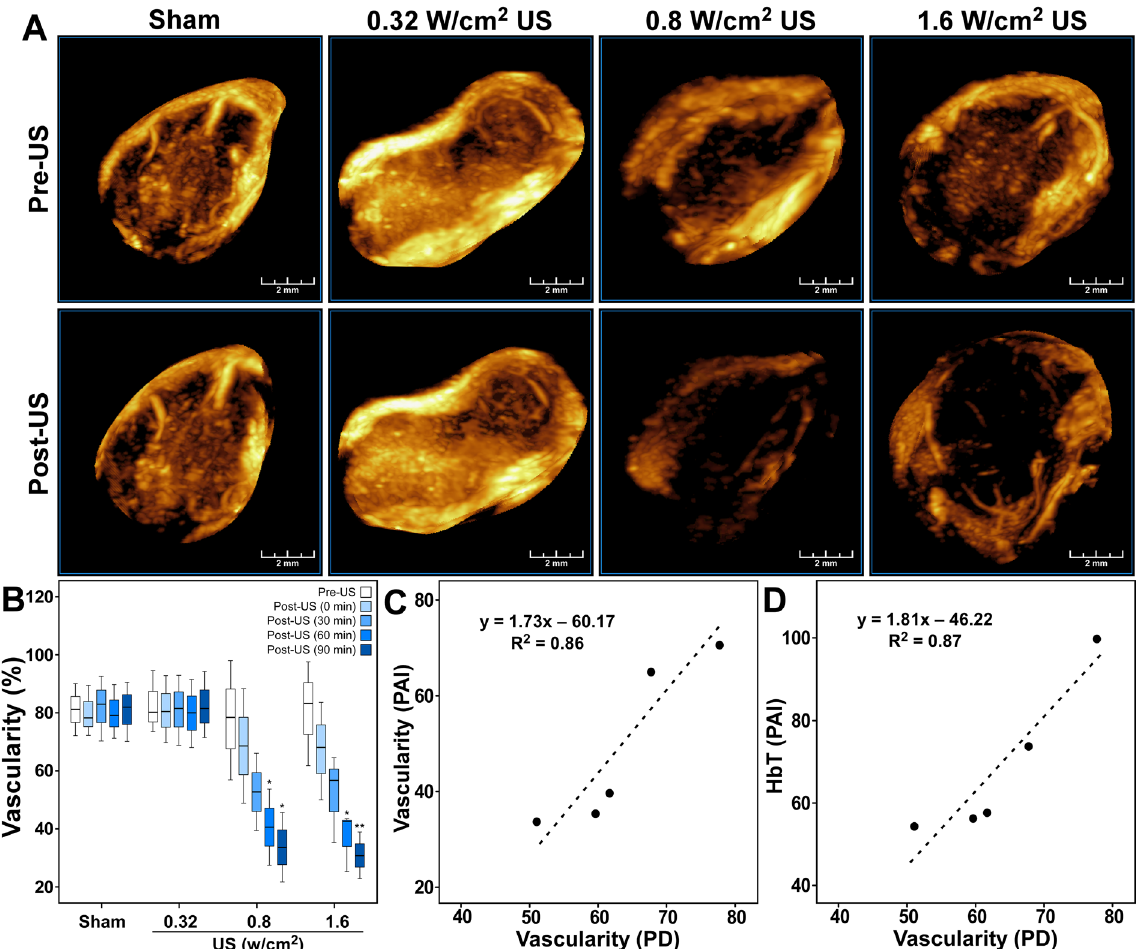
Figure 2. Power Doppler (PD) assessment of HCC tumor vascularity before and after US treatment. ( A ) Three- dimensional maximum-intensity-projection (MIP) images of the tumors displaying PD signal before (Pre-US) and 90 min after (Post-US) ultrasound therapy from representative cases. Scale bar 2 mm. ( B ) Boxplots showing the minimum, first quartile, median, third quartile, and the maximum of percentage vascularity in whole tumor volume. Mean values of percentage vascularity in the whole tumor volume for the sham, 0.32, 0.8, and 1.6 W/ cm 2 US treatment groups were calculated and compared, Pre-US versus Post-US. Statistical significance is indicated by *, **, and *** for p ≤ 0.05, p ≤ 0.01, and p ≤ 0.001 respectively. ( C ) Graph showing the correlation between the change in the ratio of colored pixels to the total number of pixels in the ROI obtained from PAI with vascularity obtained from power Doppler. ( D ) Graph showing the correlation between change in total hemoglobin (HbT) with vascularity obtained from power Doppler.